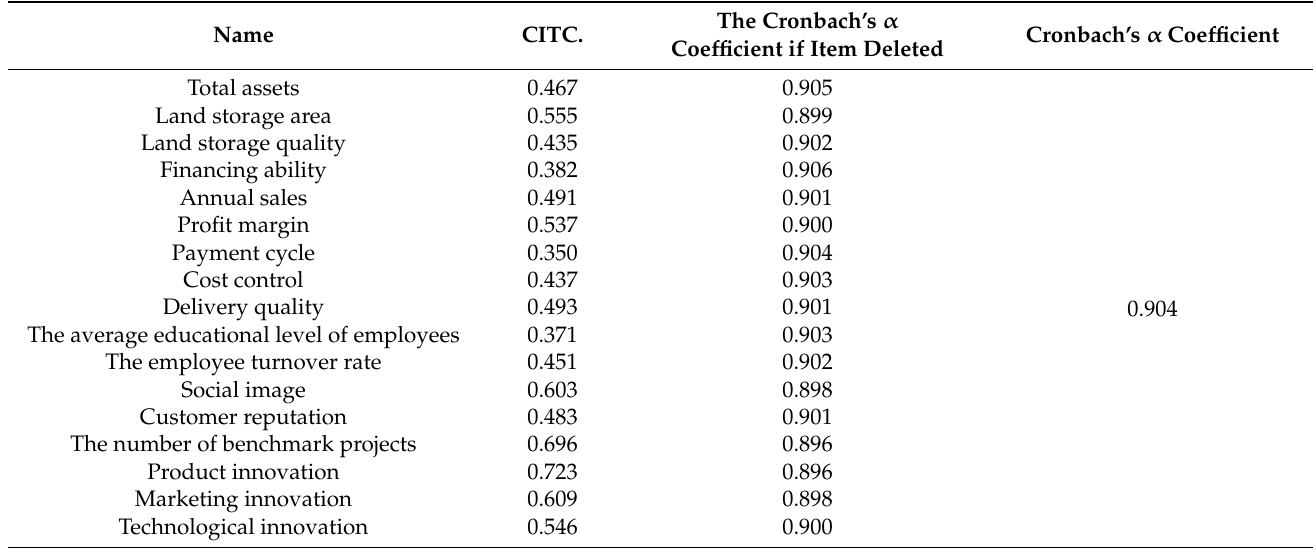
Table 4. Reliability test of the